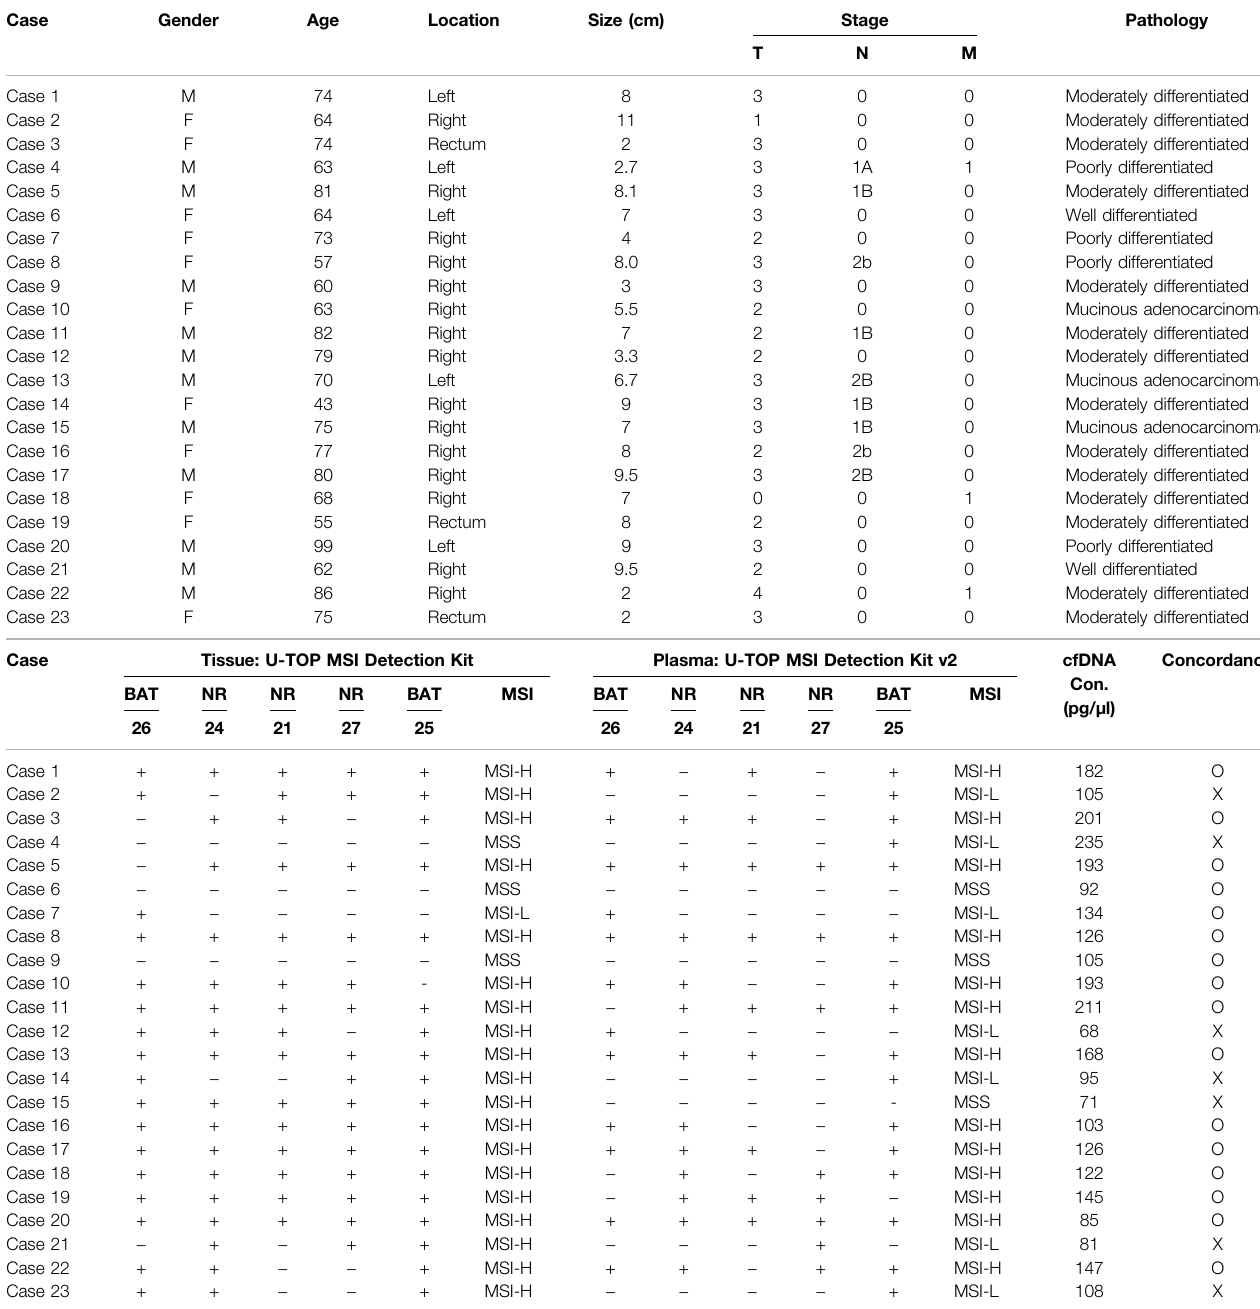
TABLE 2 | Comparison of MSI status and concordance by Tissue: U-TOP MSI Detection Kit and plasma U-TOP MSI Detection PCR. Case